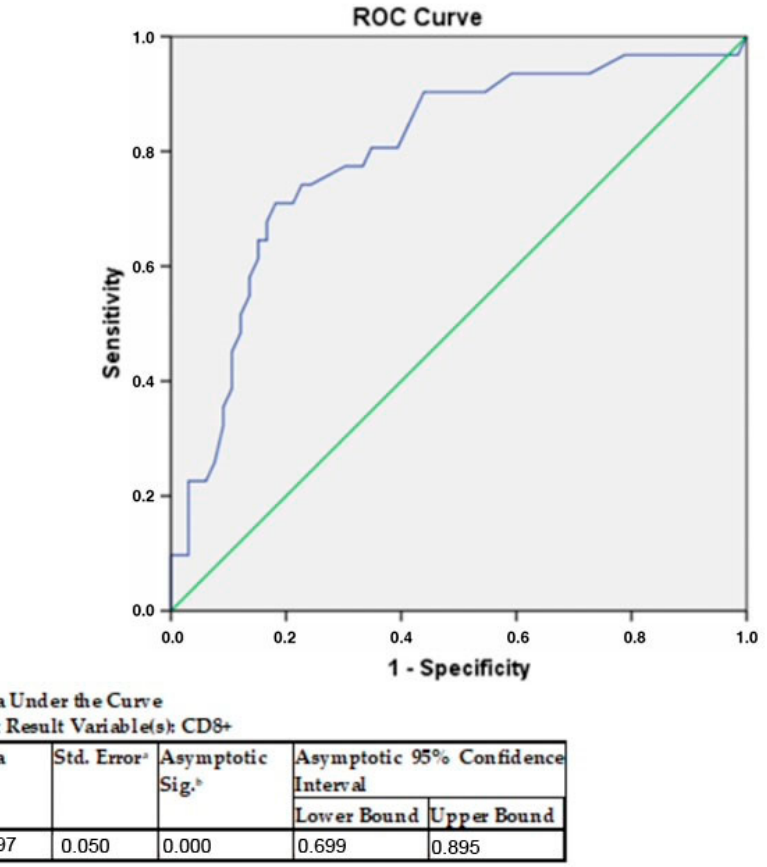
Figure 4. AUROC analysis of CD8 + cells in GC according to PD-L1 expression in tumor cells. CD8 + T cells have at least one tie between the positive actual state group and the negative actual state group. The statistics may be biased a under the nonparametric assumption. b Null hypothesis: true area = 0.5.